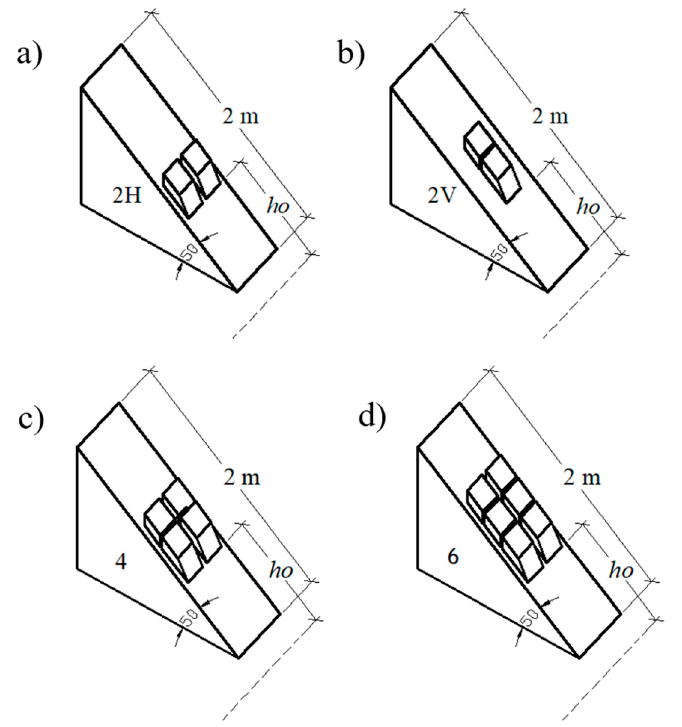
Figure 4. Arrangement of block configurations used in the tests with h o parallel to the ramp slope and measured from the still water level: ( a ) 2H; ( b ) 2V; ( c ) 4 blocks and ( d ) 6 blocks arrangement.